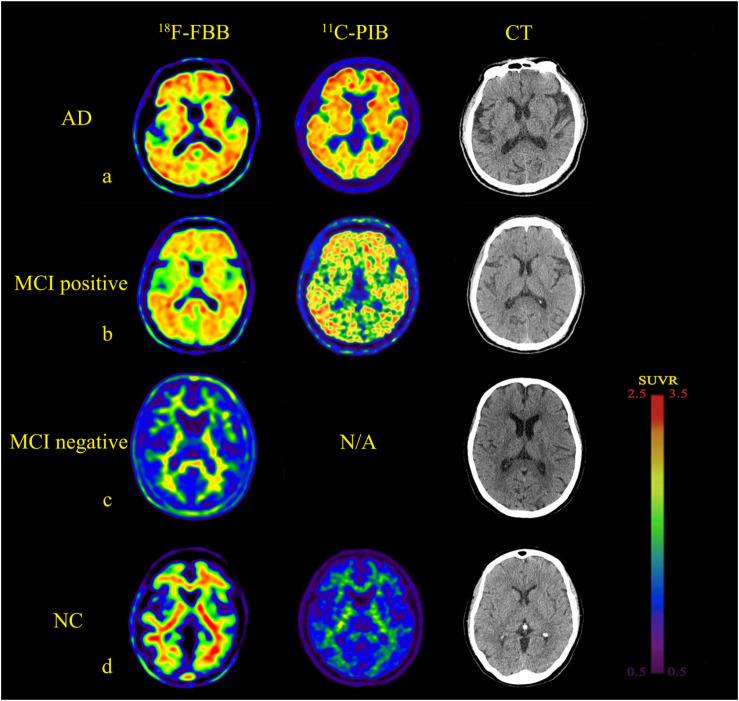
Comparison of brain axial PET images of 18F-FBB and 11C-PIB in NC, MCI, and AD for example. (a) NC participant (75-years-old, male, MMSE = 28). (b) MCI patient (73-years-old, male, MMSE = 27). (c) MCI patient (67-years-old, female, MMSE = 24). (d) Early stage AD patient (78-years-old, male, MMSE = 24). Both 18F-FBB PET/CT and 11C-PIB PET/CT images showed no amyloid deposition (a,c). Amyloid deposition in widespread cortical was almost identical in 18F-FBB PET/CT and 11C-PIB PET/CT (b,d).